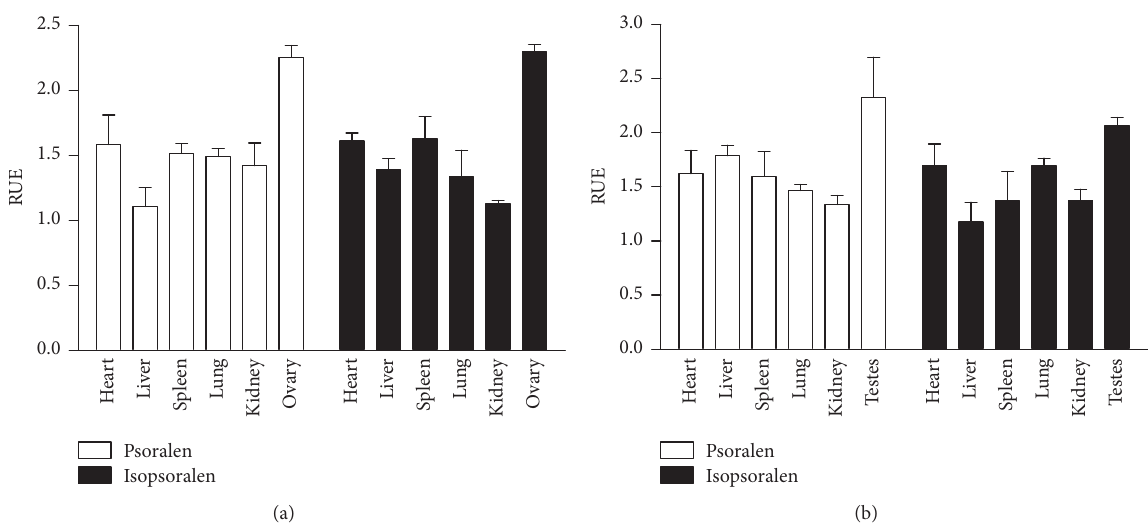
Figure 4: The RUE profiles of psoralen and isopsoralen in male and female rat tissues. (a) Psoralen and isopsoralen in female rat; (b) psoralen and isopsoralen in male rat.